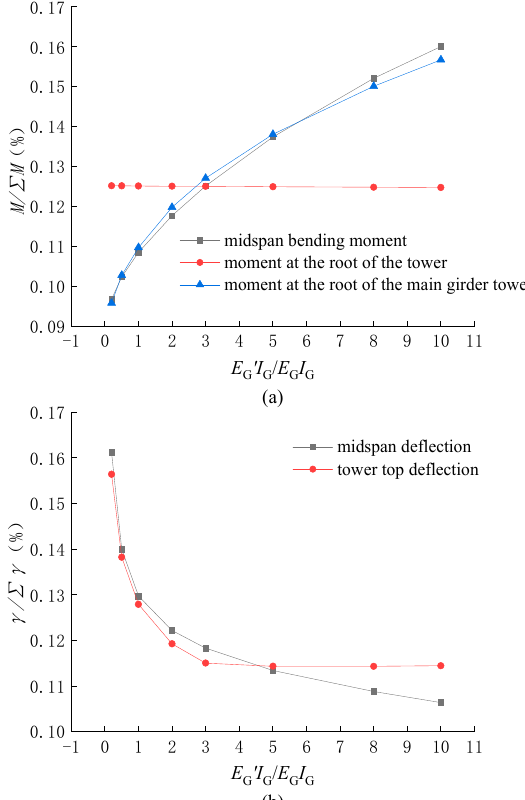
Figure 4. Effects of main girder stiffness on structural internal force and deformation. ( a ) moment; Figure 4. E ff ects of main girder sti ff ness on structural internal force and deformation. ( a ) moment; ( b ) ( b ) de fl ection.